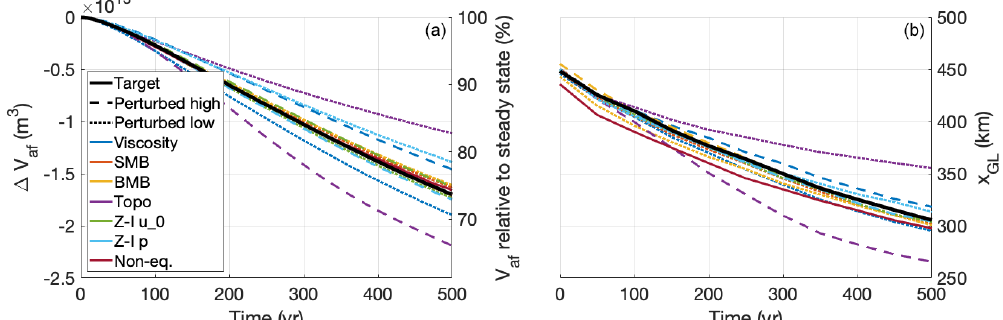
Figure 9. (a) Change in ice volume above flotation ( (cid:49)V af ), shown in absolute terms, as well as relative to the initial, steady-state volume. (b) Mid-stream grounding-line position ( x GL ) over time in the perturbed retreat simulations of experiment II. Colours indicate the perturbed parameter; line styles indicate the direction of perturbation. The unperturbed simulation is shown by the solid black